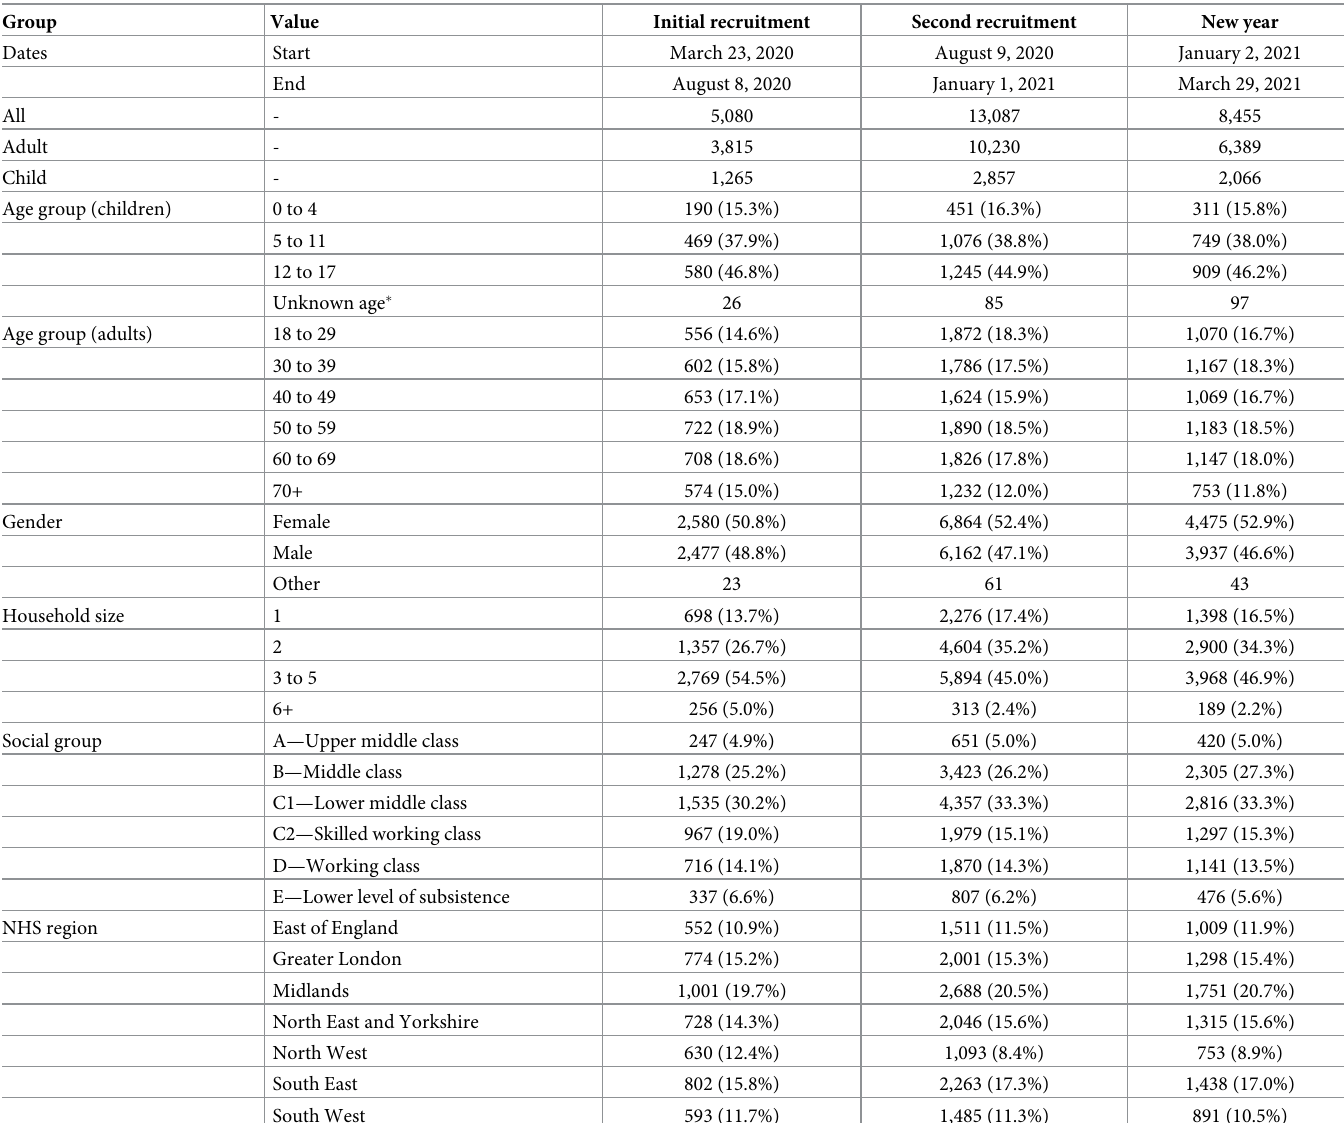
Table 3. Participant